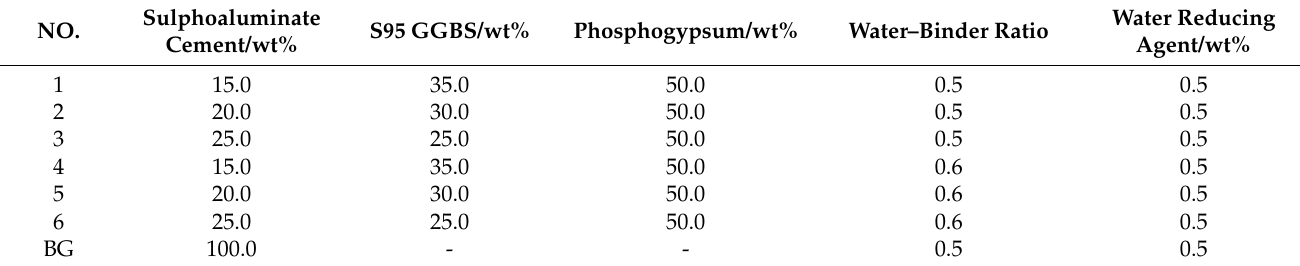
Table 5. The mixing ratio of the mortar